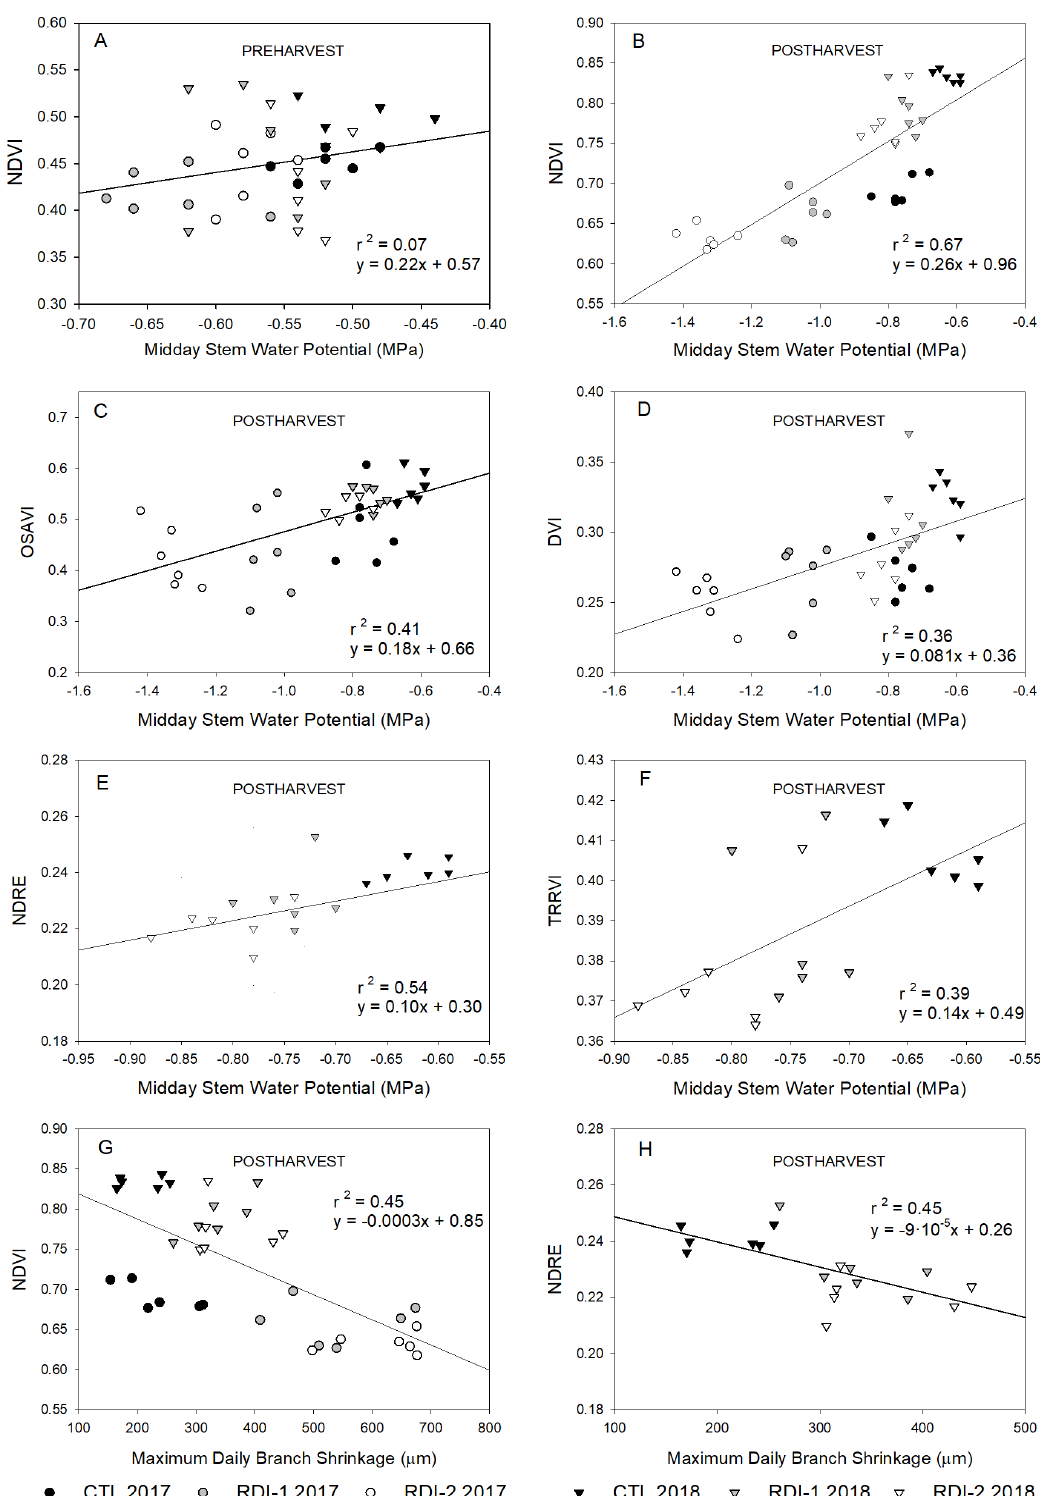
Figure 5. Linear relationships between midday stem water potential and NDVI (normalized difference vegetation index) ( A , B ), OSAVI (optimized soil adjusted vegetation index) ( C ), DVI difference vegetation index ( D ), NDRE (normalized difference red edge) ( E ), and TRRVI (transformed red range vegetation index) ( F ). Linear relationships between maximum daily branch shrinkage and NDVI ( G ) and NDRE ( H